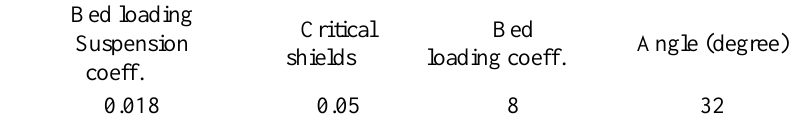
Table2. Specifications of